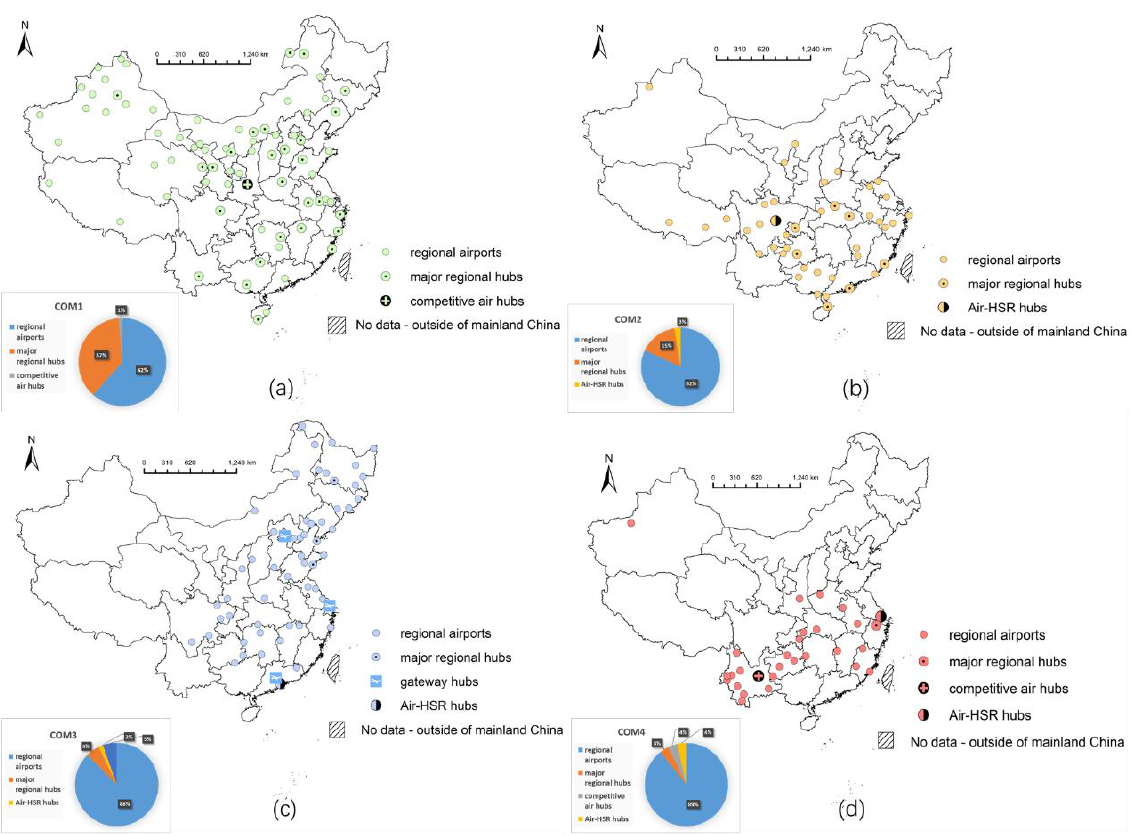
Figure 3. Airport clusters in the 4 airport communities in 2014: (a) Community 1, (b) Community 2, (c) Community 3, (d) Community